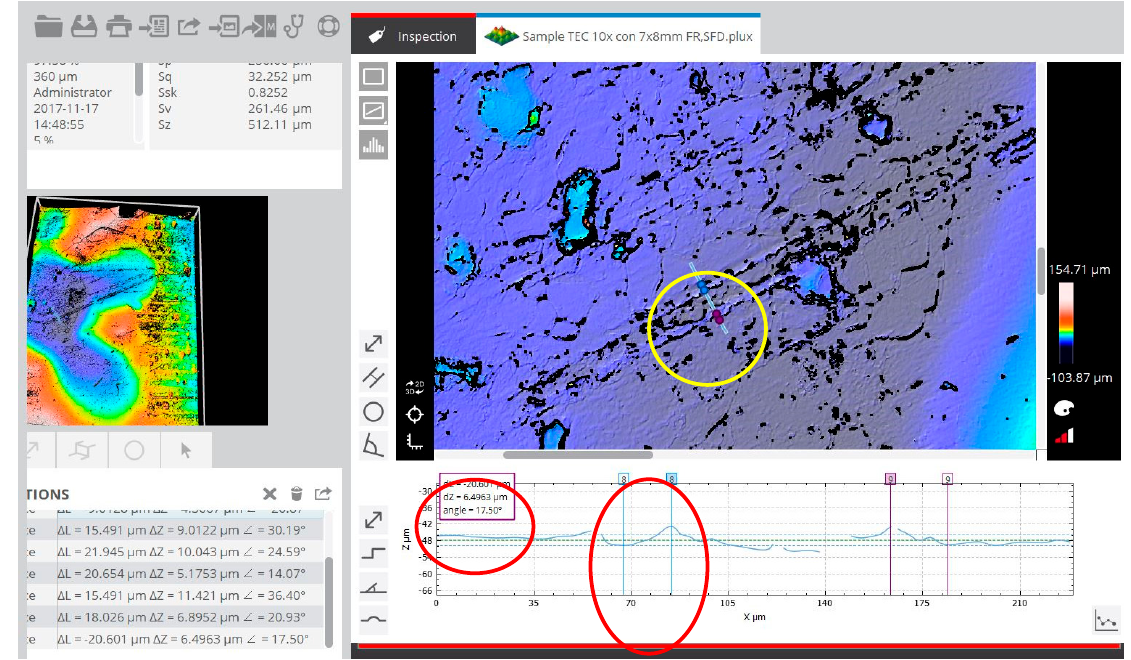
Figure A1. Screenshot from SensoScan software illustrating the profile measurement tool over the selected scratches (top), and the distance annotation tool measuring the selected profile